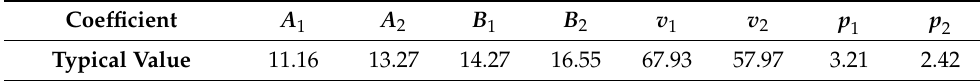
Table 1. Fitting factors for interface and bulk fracture modes.